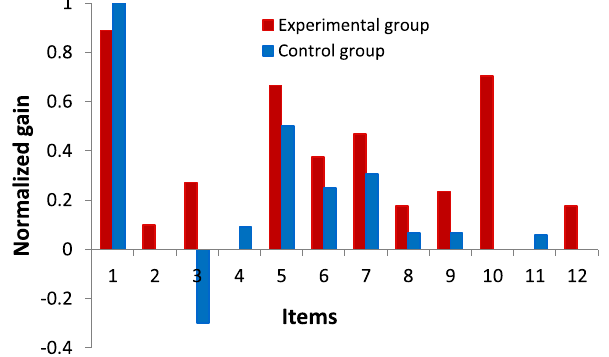
FIG. 1. Between group comparison of Hake ’ s normalized gains for individual items (both tiers).